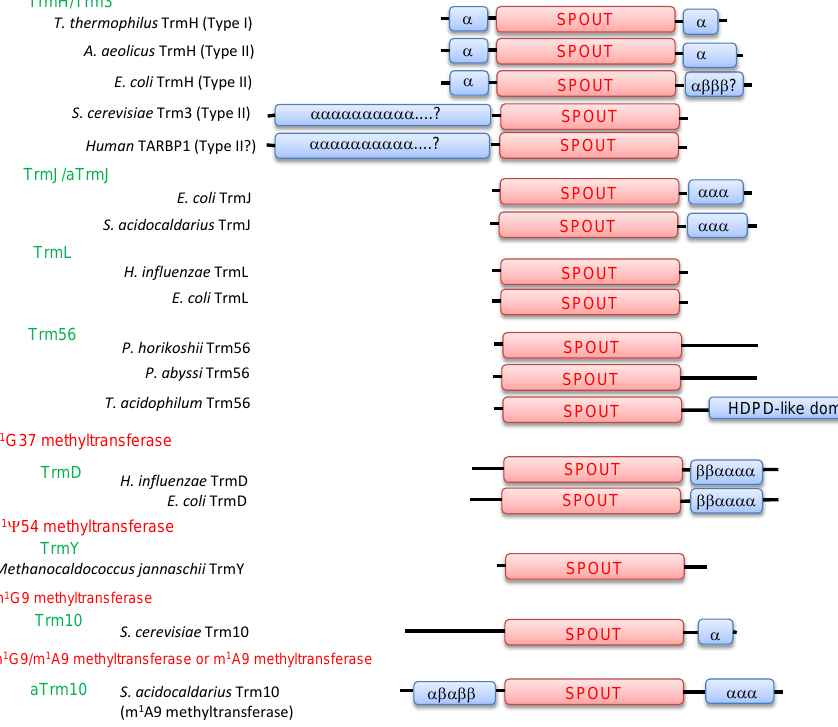
Figure 5. Domain structures of tRNA methyltransferases with a SPOUT fold. This figure is based on that by Tkaczuk et al. [29] and has been modified by data from recent crystal structure studies. The catalytic domain with a SPOUT fold is represented as “SPOUT”. “ α ” and “ β ” represent α -helices and β -strands, respectively. The HDPD-like domain indicates the His-Asp phosphodiesterase-like domain. S. cerevisiae : Saccharomyces cerevisiae ; H. influenzae : Haemophilus influenzae ; P. horikoshii : Pyrococcus horikoshii ; P. abyssi : Pyrococcus abyssi ; T. acidophilum : Thermoplasma acidophilum ; S. acidocaldarius : Sulfolobus acidocaldarius